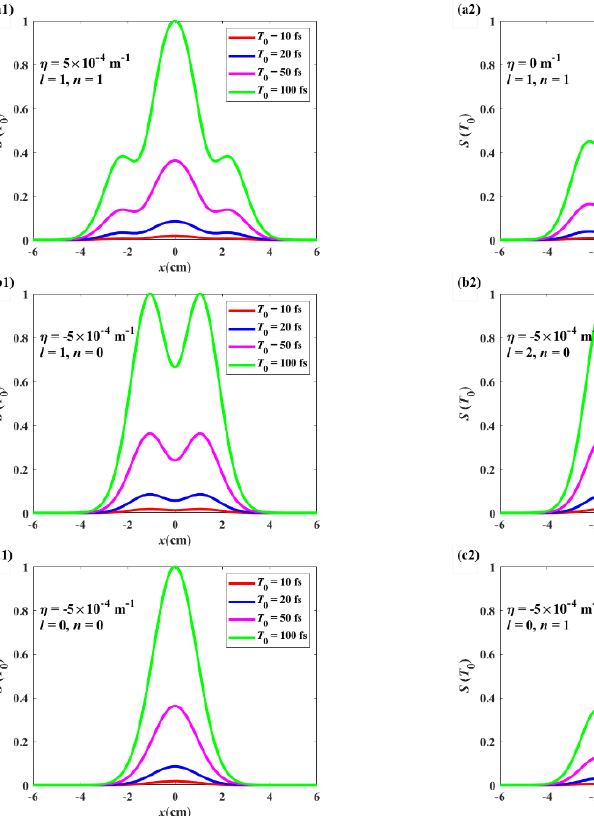
= 1 × 10 − 14 m 3 − α ). n